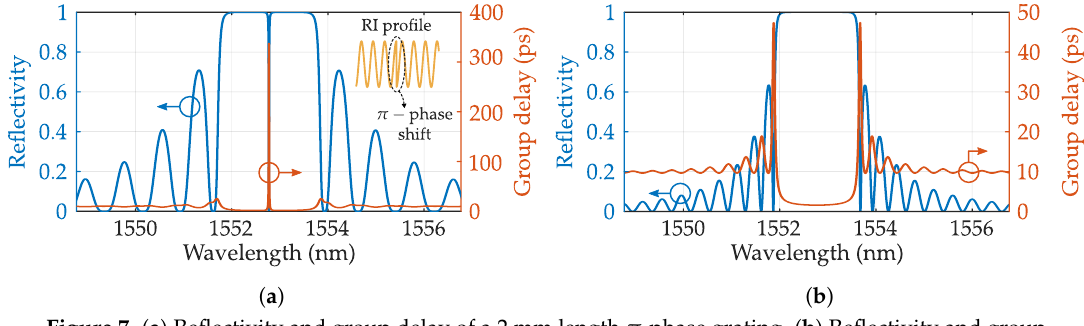
Figure 7. ( a ) Reflectivity and group delay of a 2 mm length π -phase grating. ( b ) Reflectivity and group delay of a 2 mm length slow-light